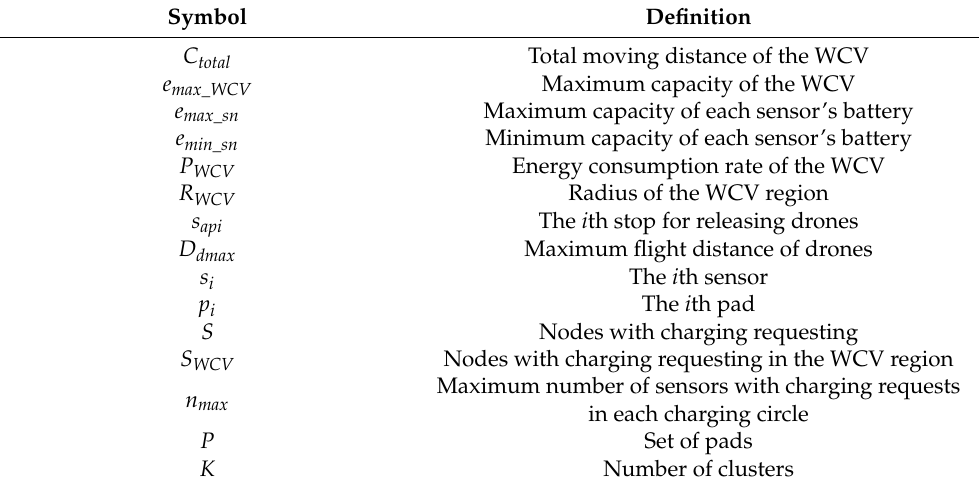
Table 2. Symbols and definitions.